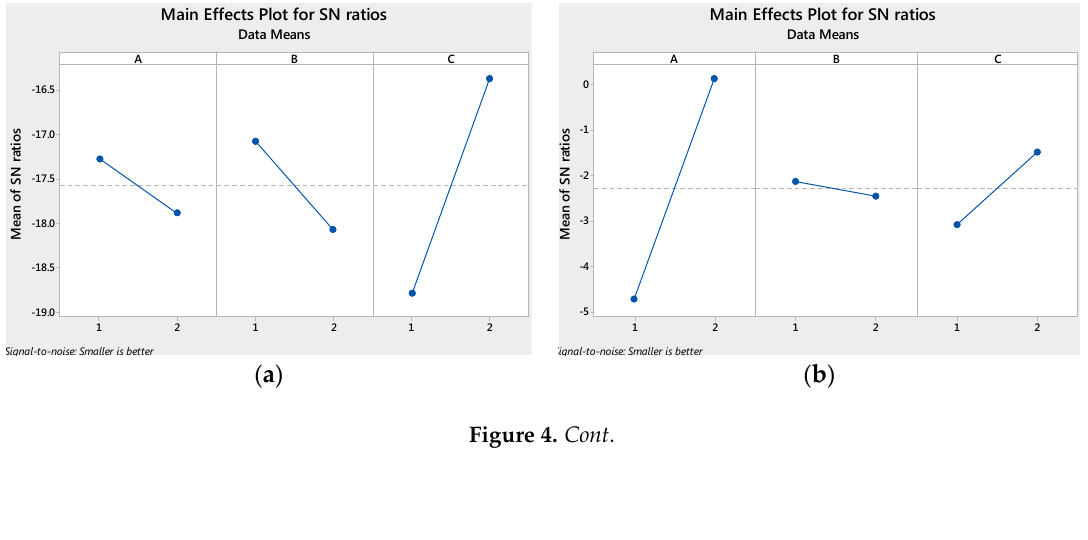
Main Effects Plot for SN ratios Data Means